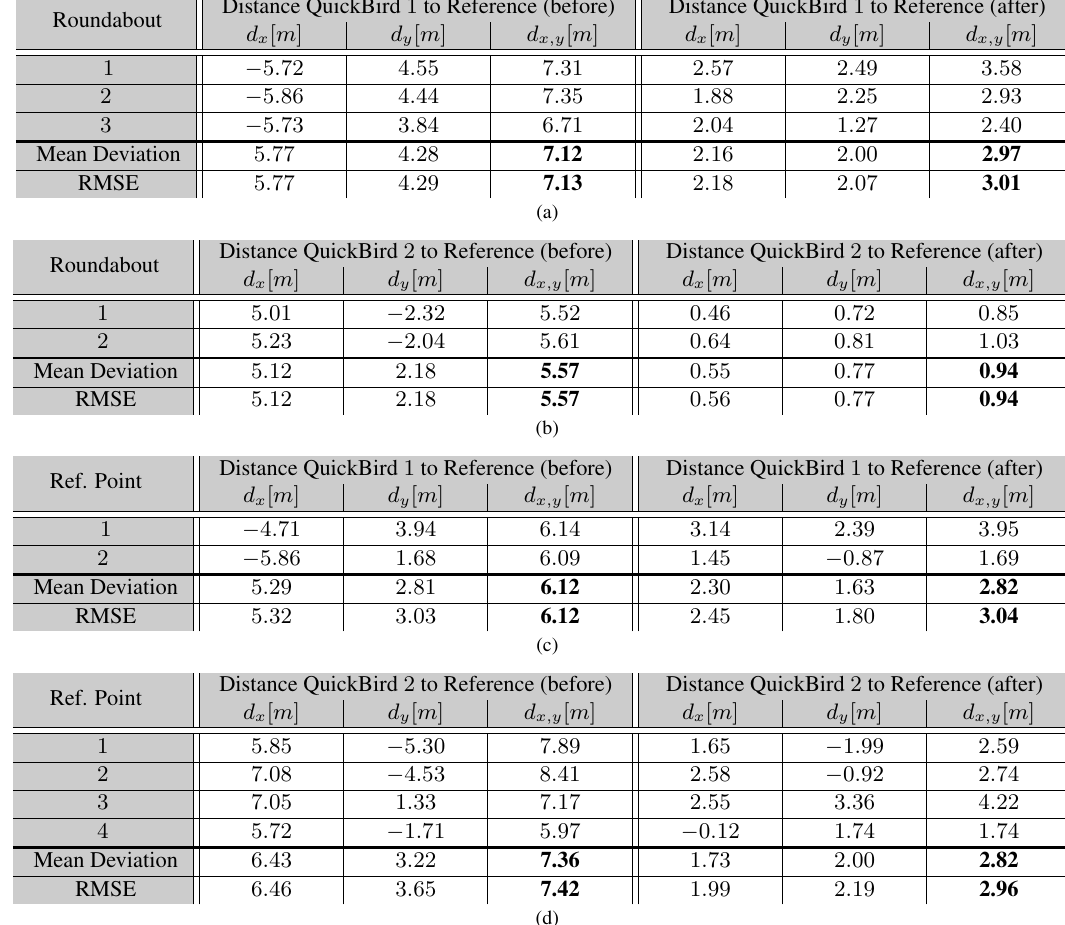
Table 2: The distances d x and d y in x - and y -direction and the Euclidean distances d x,y between the detected roundabout centers (reference points) from the two QuickBird images and from the reference dataset, the mean deviation, and the root mean square error (RMSE). The x -direction corresponds to easting and the y -direction to northing coordinates. only with two or three GCPs in one image and a subpixel im- age translation, the geometric accuracy of the optical image is improved. Additionally, the alignment of different optical image scenes with a small overlapping area is achieved with the pro- posed